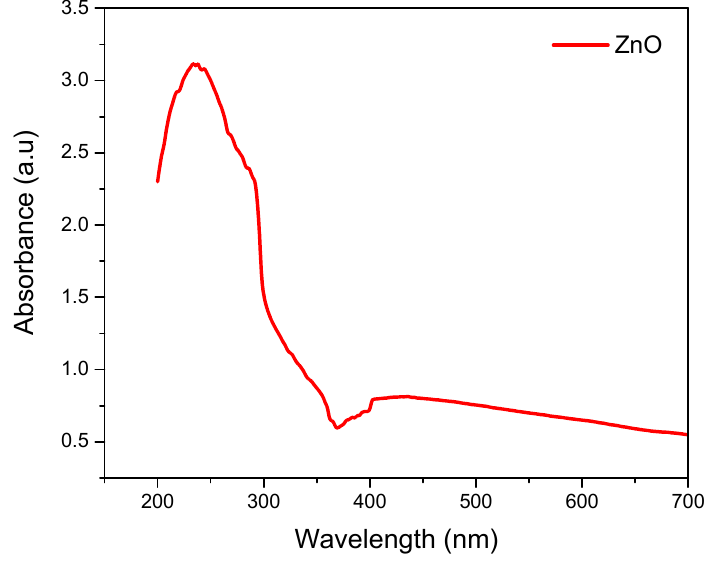
Figure 3. UV-vis profile of as-produced ZnO nanoparticles before coating over cotton